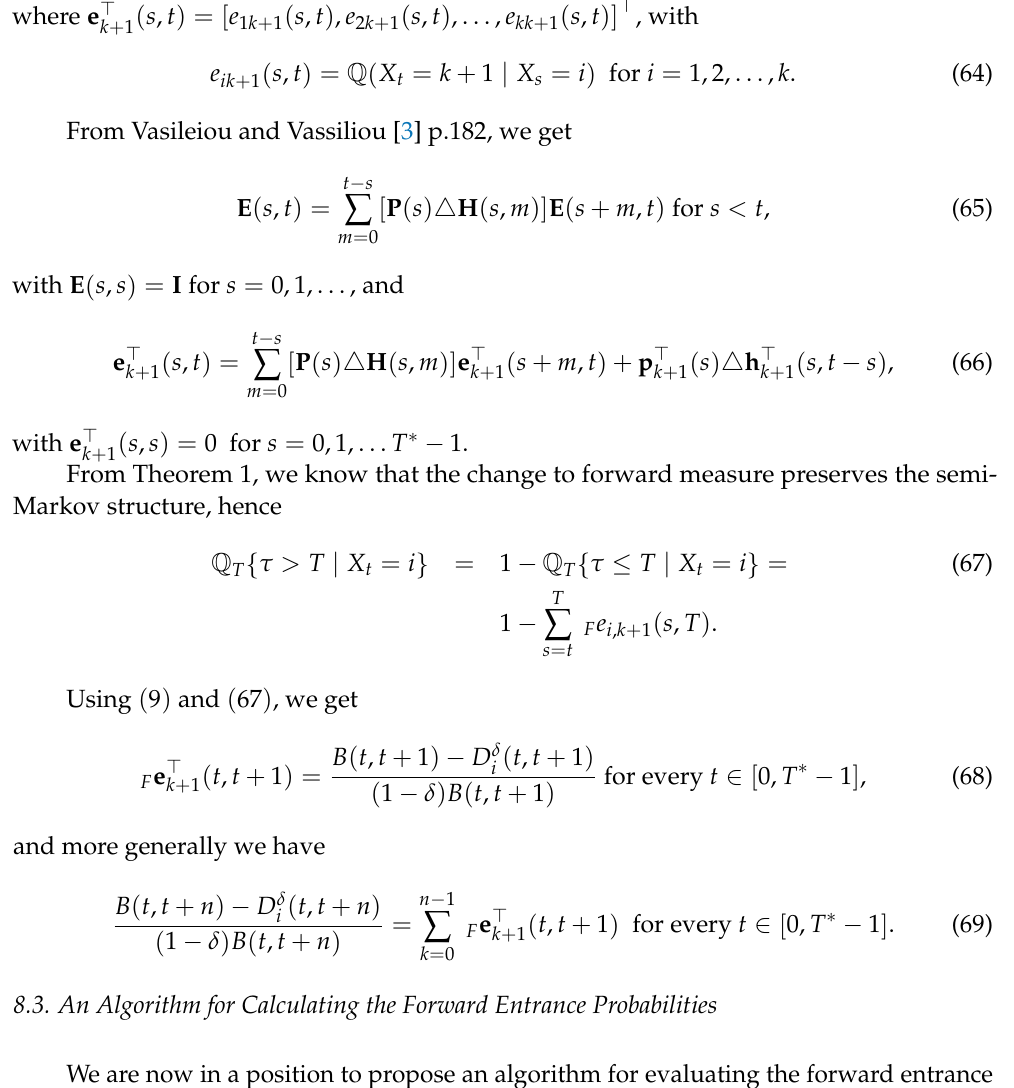
Algorithm 8.1. (Risk Premium